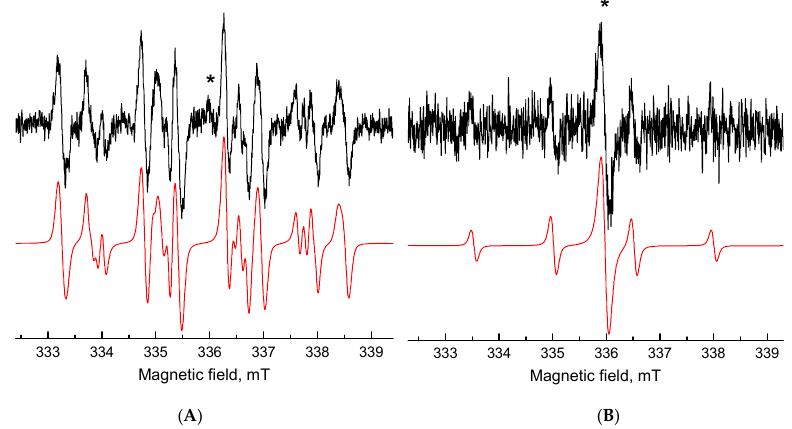
Figure 4. Experimental ( – ) and simulated ( – ) EPR spectra obtained after 13 min UVA exposure of berberine derivative 2 in the presence of DMPO spin trap under air in: ( A ) water/DMSO (2:3, v : v ) and ( B ) water. (Initial concentrations: c 0 (berberine derivative 2 ) = 0.8 mM, c 0 (DMPO) = 0.042 M, λ max = 365 nm, irradiance 13 mW · cm − 2 ).